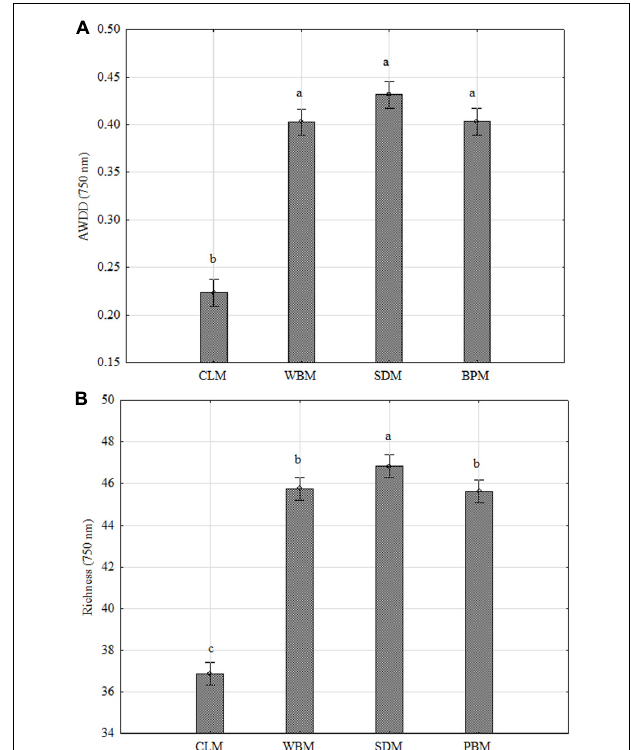
FIGURE 3 | FF plate R (cid:13) biodiversity indices based on carbon compounds utilization ability of Petriella setifera as influenced by preculturing. (A) Average Well-Density Development index (AWDD), (B) substrate Richness (R). Explanations: SDM - oak sawdust medium, BPM - beet pulp medium, WBM - wheat bran medium, CLM - control medium. The vertical bars indicate the confidence intervals at 0.95. Different letters above the bars indicate errors in the significance of differences ( α = 0.05) between the mean values of OD [Tukey’s test ( p < 0.05)], n = 3.